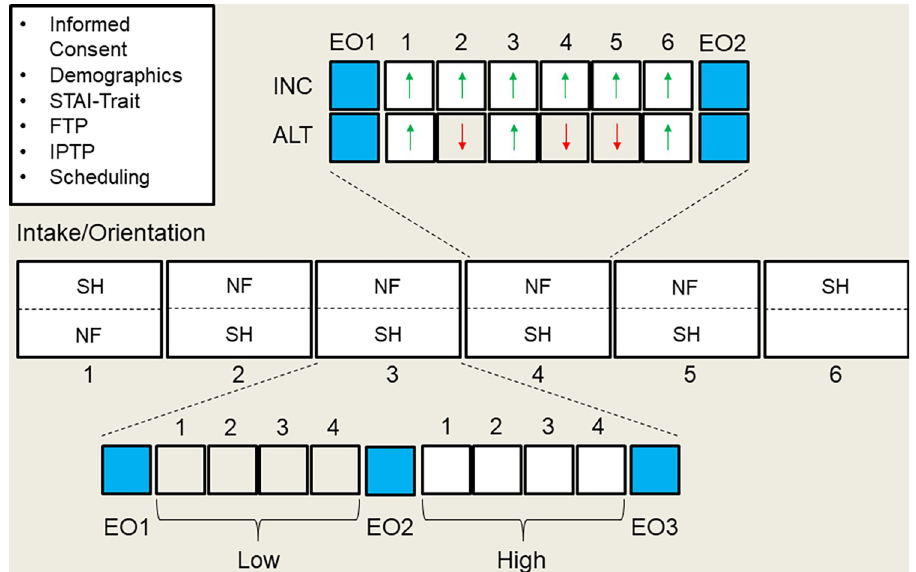
Fig 1. Task design. Experiment design illustrating the Intake/Orientation session, five sessions of NF training and six sessions of Go-NoGo SH task testing. Insert above shows six blocks (6 trials/block) of NF training for the INC (all increase Fm θ ) and ALT (3 increase and 3 decrease Fm θ randomly assigned) groups with eyes-open rest periods before and after NF training (EO1-EO2). Insert below shows four blocks (90 trials/block) in both Low and High time stress conditions (counterbalanced order by subjects and sessions), with eyes-open rest periods before and after each SH task condition (EO1-EO3).